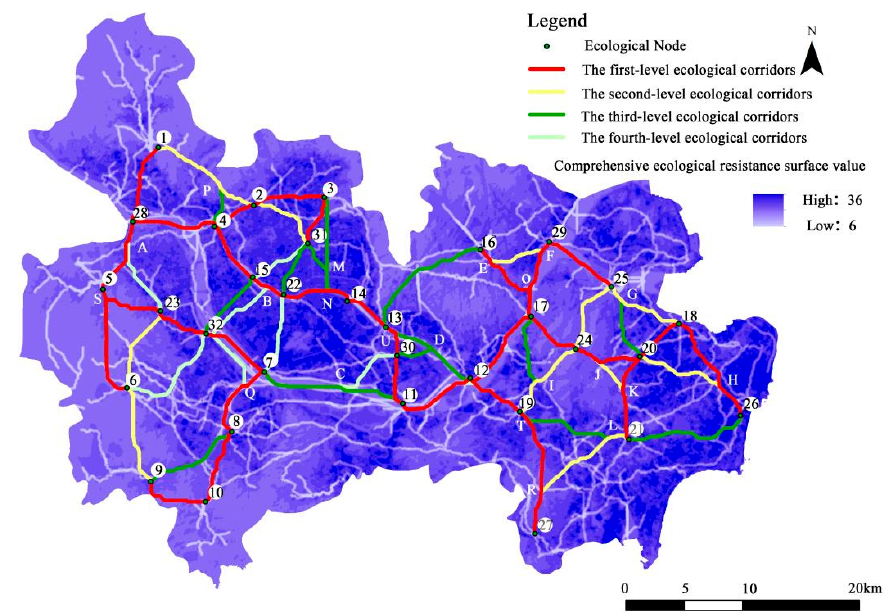
Figure 7. Distribution map of the ecological corridors.